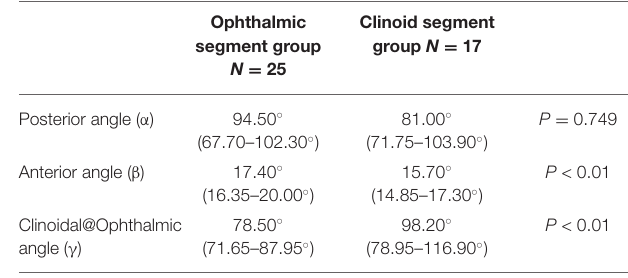
TABLE 4 | A comparison of the carotid siphon angle morphology of aneurysms originating from between the ophthalmic segment (C6) and clinoid segment (C5). Ophthalmic segment group